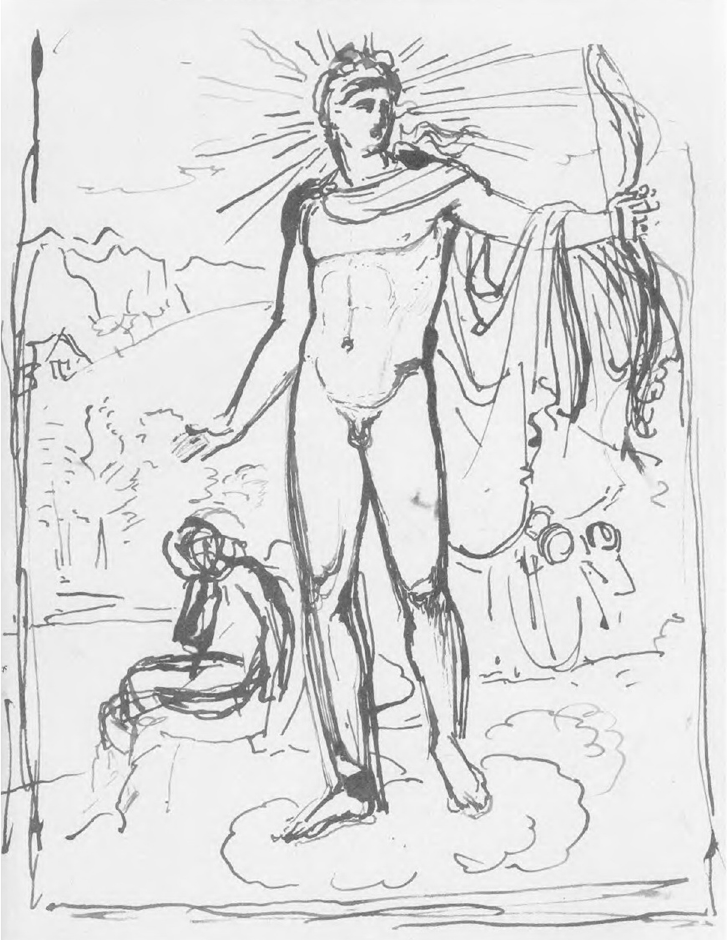
Figure 21. Orest Kiprensky. Apollo Smiting Python , 1818–19. State Russian Museum, Saint Peters‑